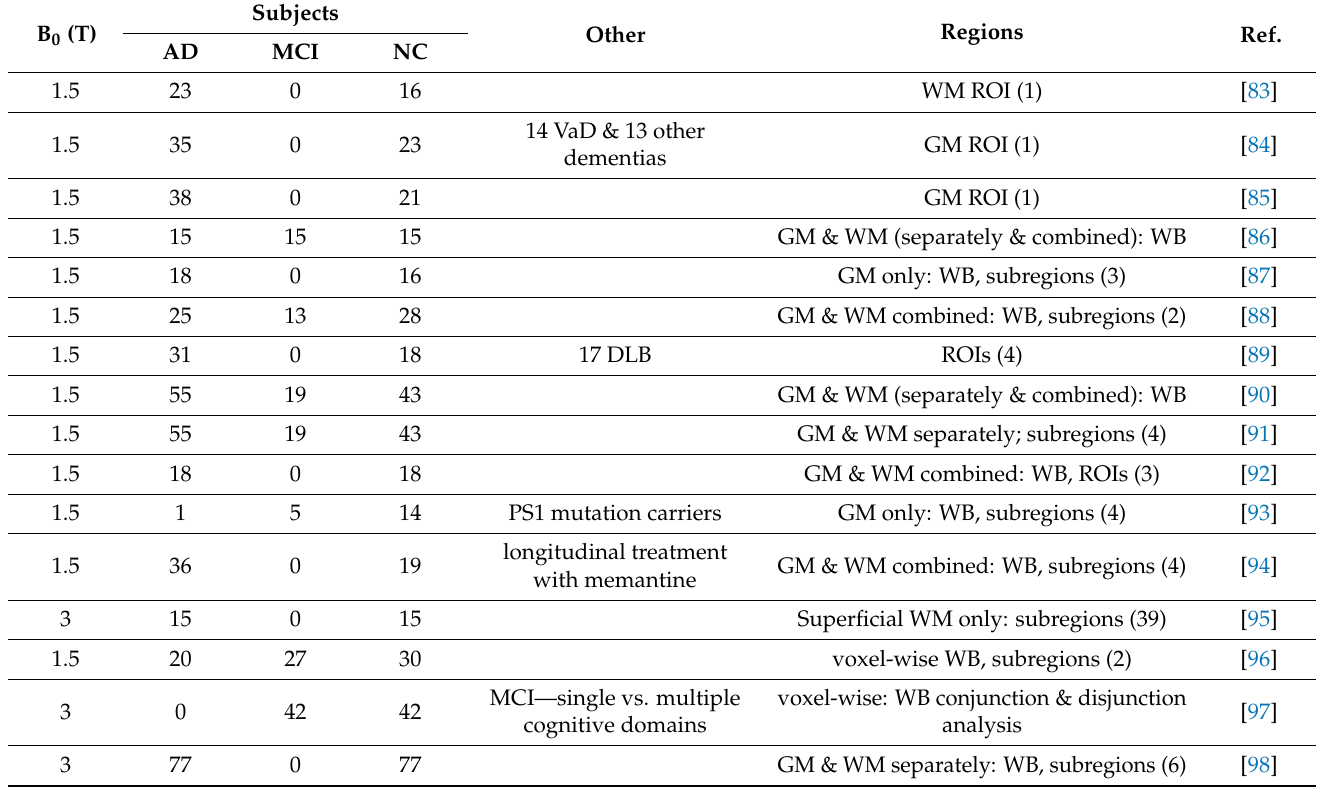
Table 1. Human studies conducted using MT